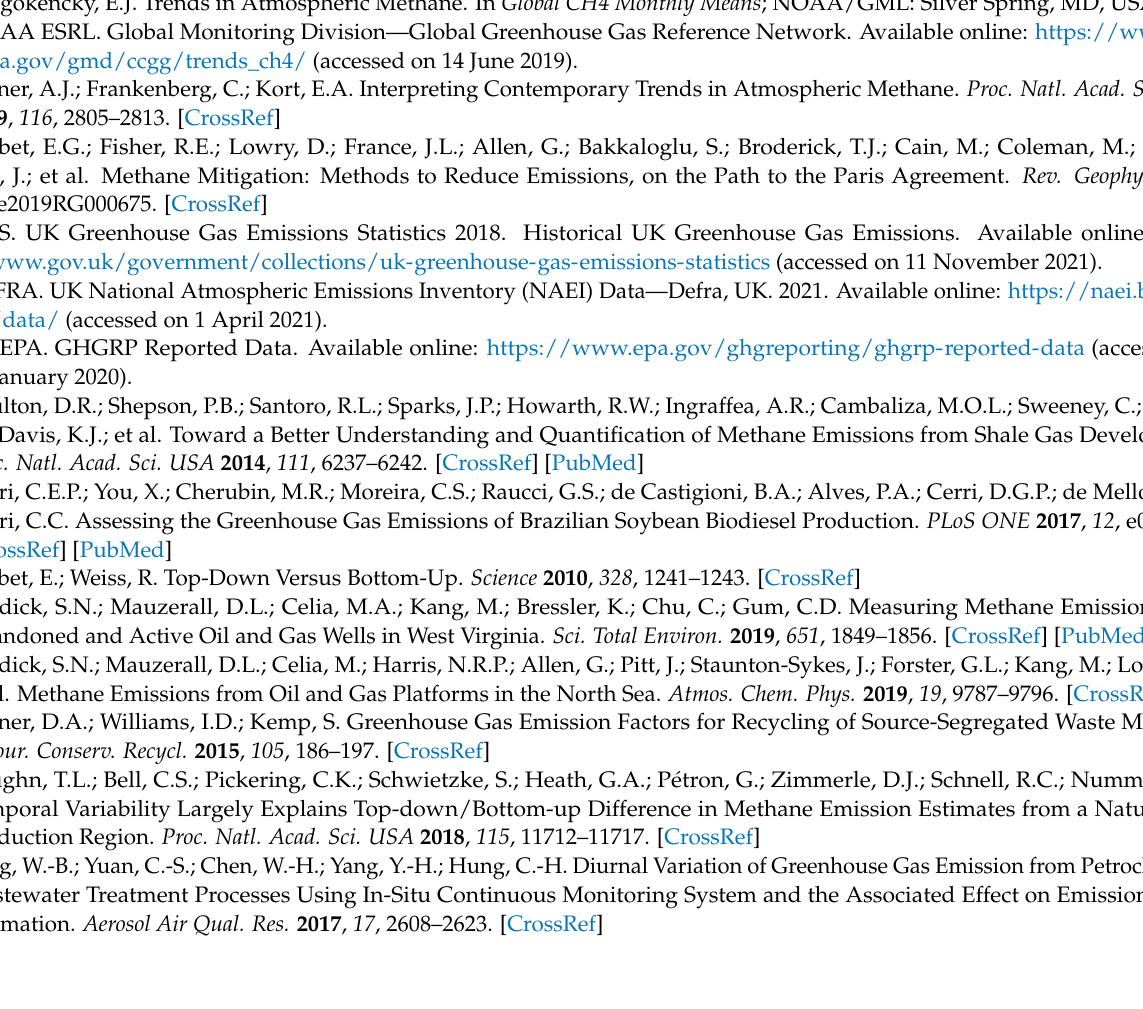
Figure S2: Driving survey sampling area sources; Table S1: Pasquill Gifford Stability Class lookup table; Table S2: Data input to Equation 1 to calculate methane emission from a point source; Table S3: Data input to WindTrax to calculate methane emission from an area